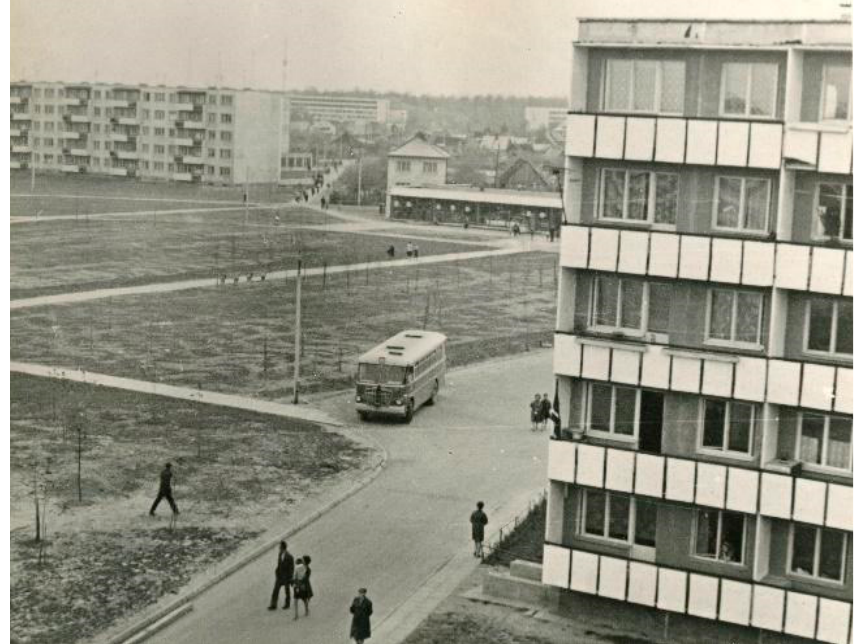
Figure 6. Soviet neighbourhood in Kaunas, designed by Neringa Di č iuvien ė , Reda Dringelien ė , Alvydas Pranas Steponavi č ius, Raimonda Augustien ė , and Gražina Miškinien ė , built in 1963, photo by an unknown photographer, from the personal collection of V.Petrulis.